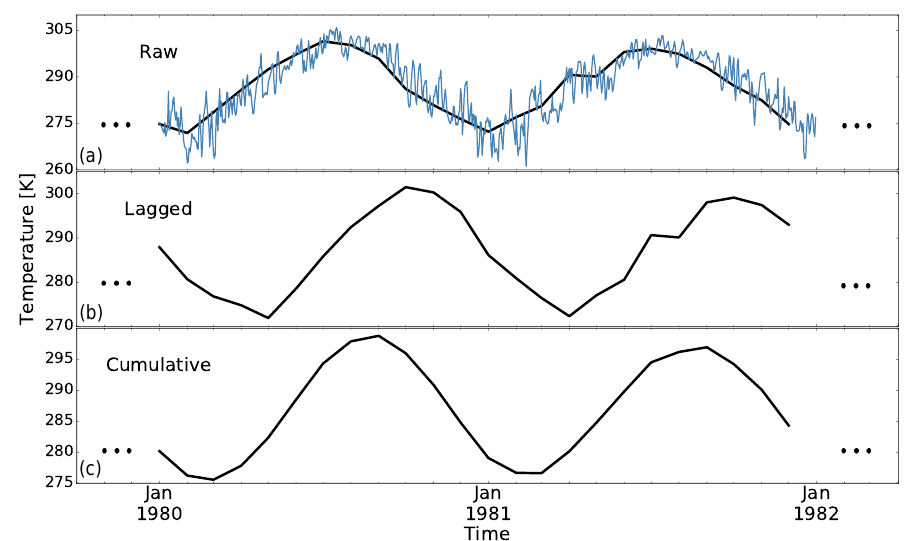
Figure 3. Example of lagged and cumulative variables extracted from a temperature time series. On top is part of a raw daily time series with its monthly aggregation. In the middle is the 4-month lag-time monthly time series. On the bottom is the corresponding 4-month cumulative variable. The pixel corresponds to a location in Kentucky, USA (lat: 37.5 ◦ , long: − 87.5 ◦